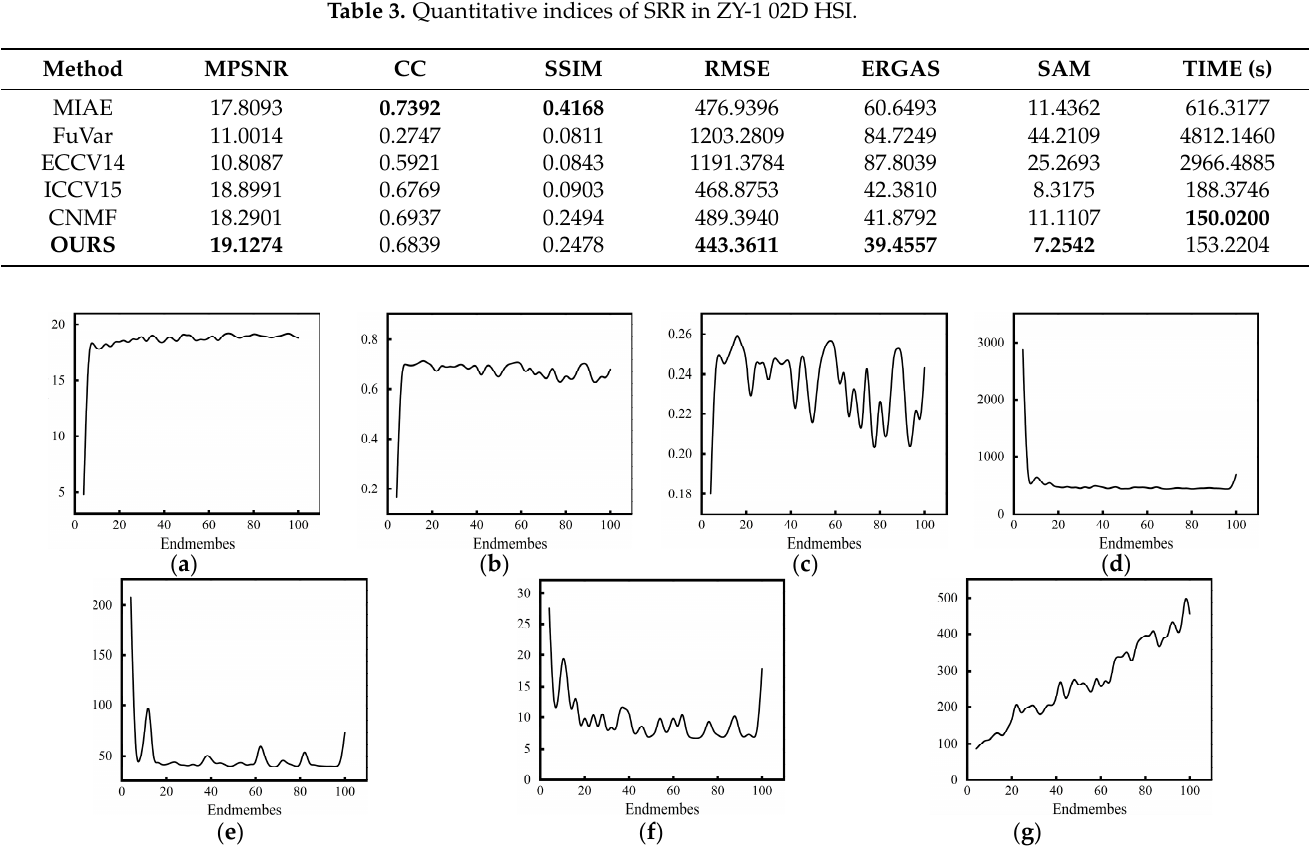
Figure 7. Effect of endmember number on the proposed method in the ZY-1 02D experimental data. ( a ) MPSNR; ( b ) CC; ( c ) SSIM; ( d ) RMSE; ( e ) ERGAS; ( f ) SAM; and ( g ) TIME.